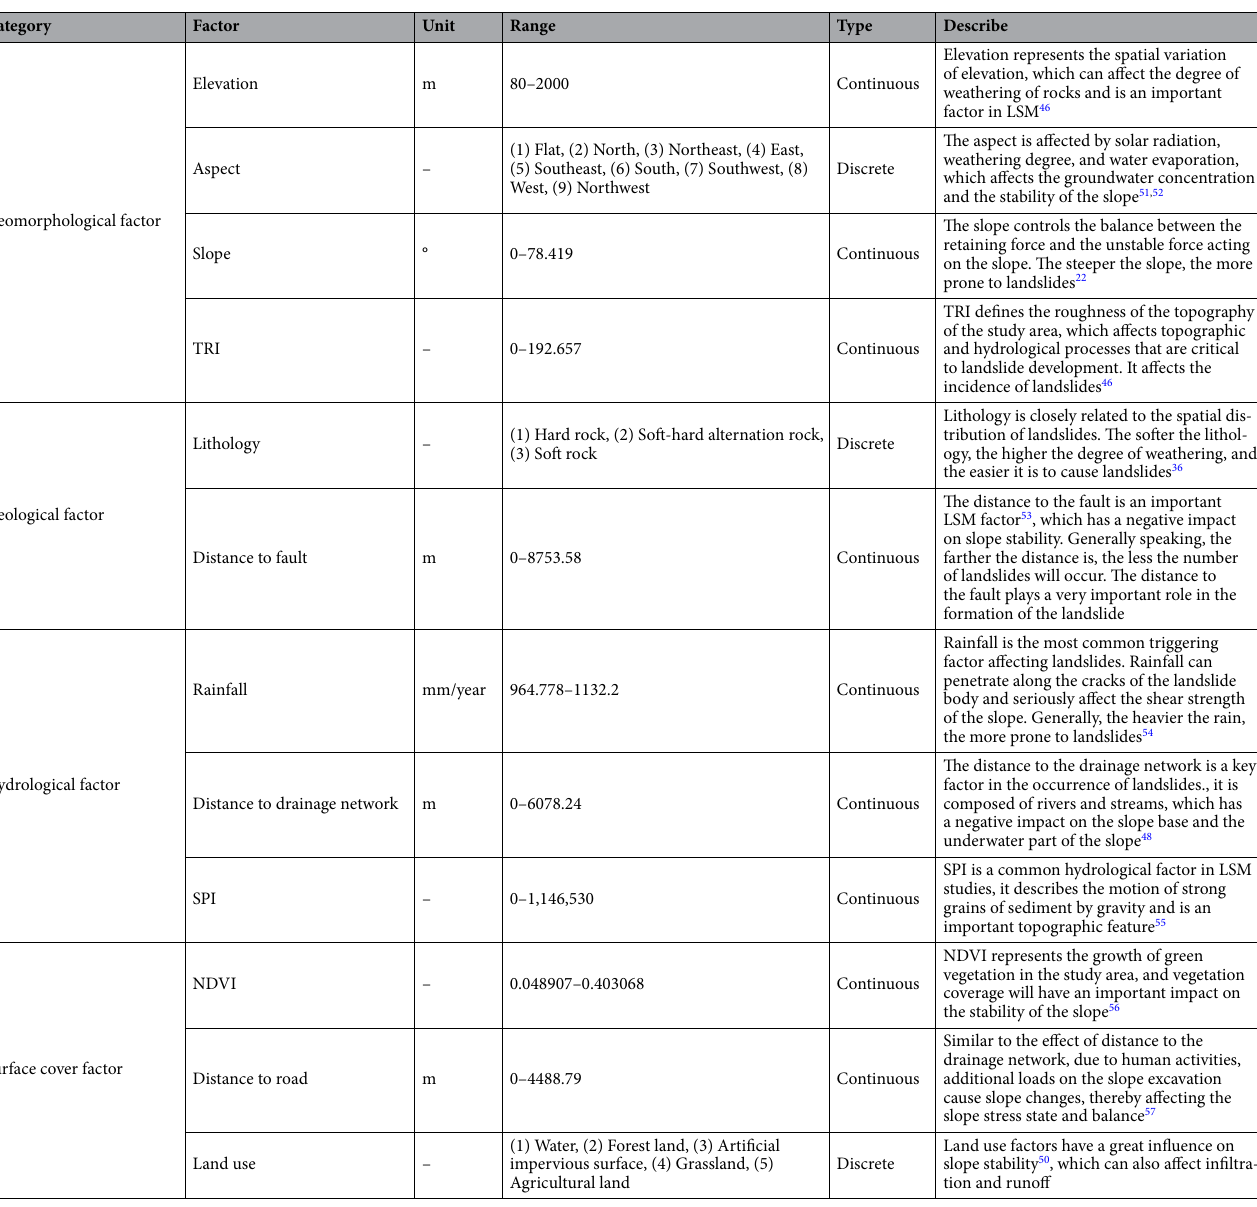
Table 3. LSM factor selected in this